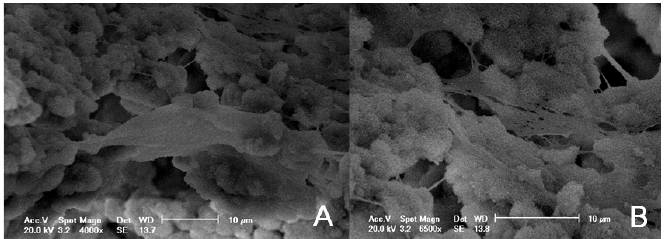
FIGURE 5 - Scanning electron micrography of the cells adhered on the macroporous CPC surface after 15 days of culture. A) Magnification of 4000x, B) Magnification of